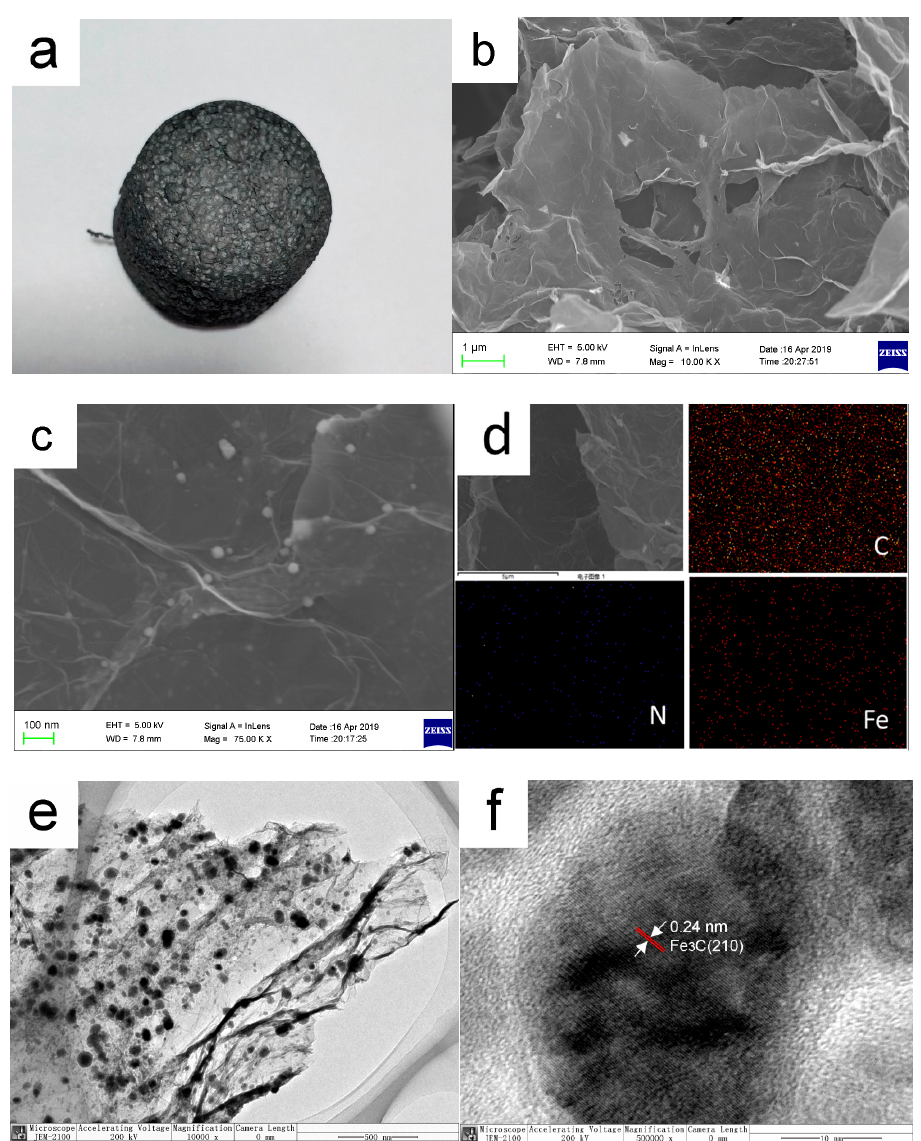
Figure 2. The morphology of self-assembled nano-Fe 3 C@RGO aerogel: ( a ) the macroscopic morphology; ( b , c ): SEM; ( d ) mapping; ( e , f ):